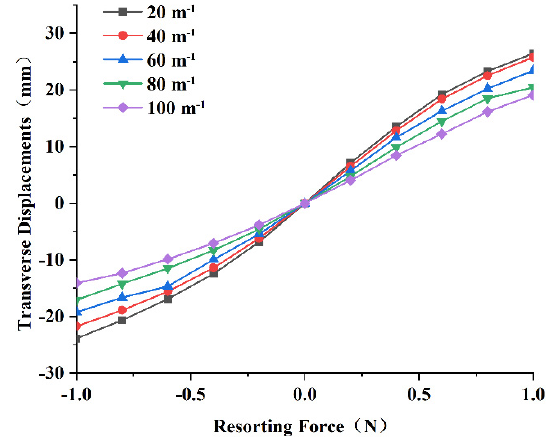
Figure 6. Displacement-restoring force curve of the curve-shaped beam.